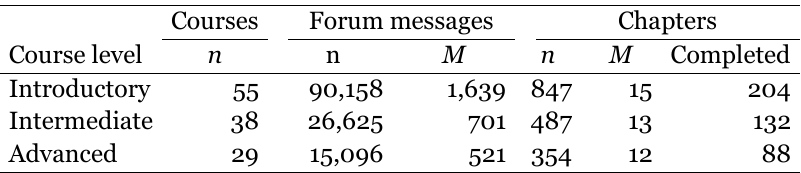
Learner Activity According to Course Level